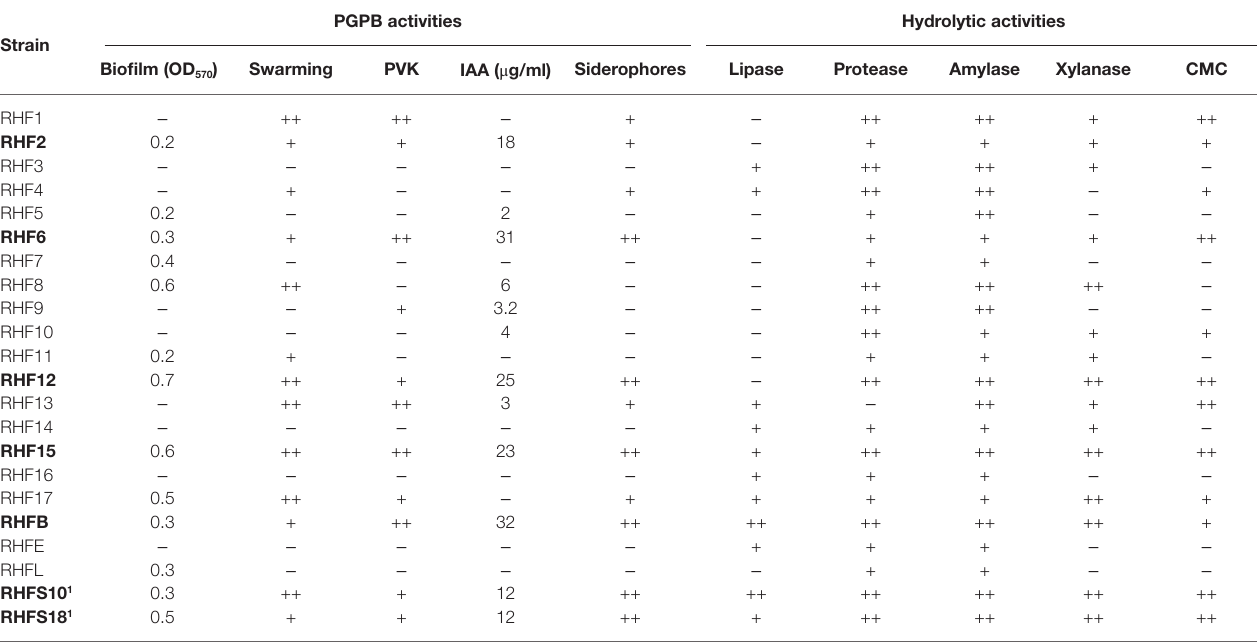
TABLE 2 | Summary of plant growth-promoting and biocontrol traits exhibited by 20 spore-forming bacteria